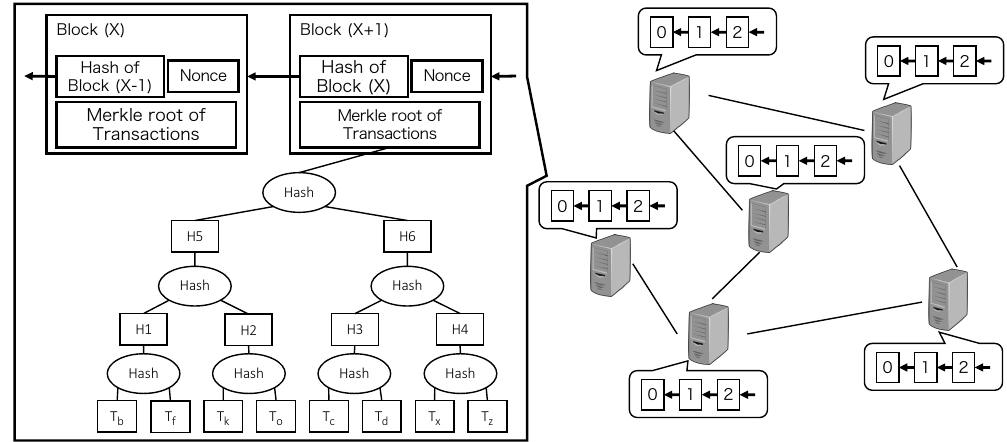
Figure 1. Blockchain